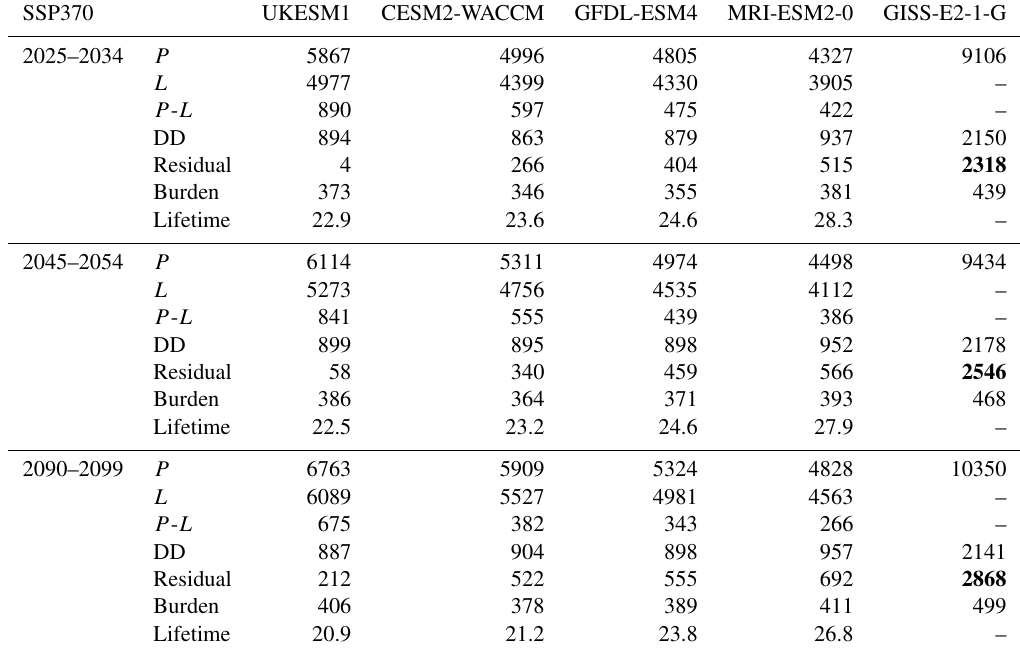
Table 2. Same as Table 1 but for ssp370. As before, the Residual quantities for GISS-E2-1-G were calculated differently from the others, being based on dynamical transport rather than budget closure, and so this is indicated in